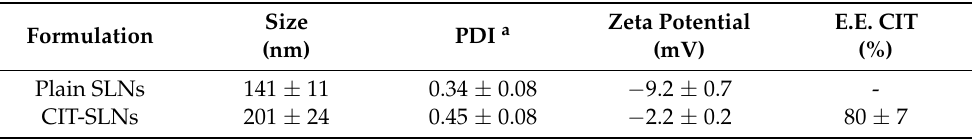
Table 1. Physicochemical characterization of prepared SLNs. All values are expressed as mean ± standard deviation of at least eight replicates ( n =